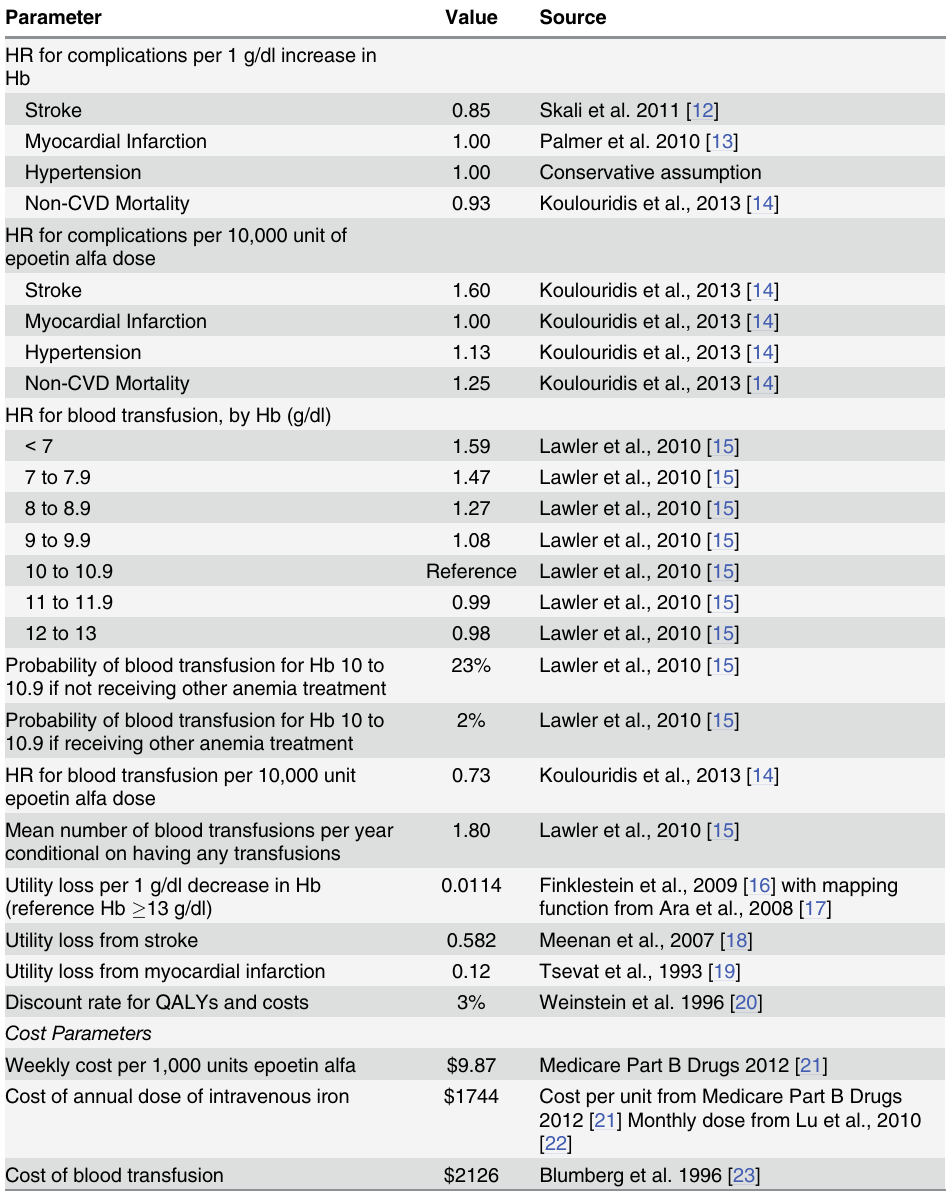
Table 1. Key parameters used in the CKD Health Policy Model related to anemia, anemia treatment, complications of anemia and its treatment, and anemia treatment costs in persons with CKD stages 3 and 4.